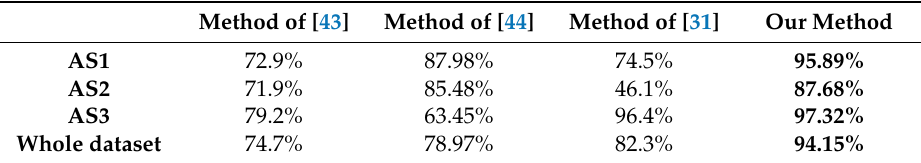
Table 2. Comparisons of classification accuracy with different